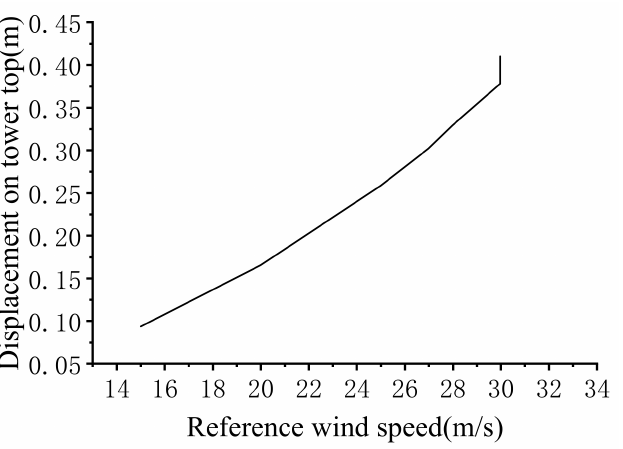
Figure 8. The variation curve of transmission tower top displacement with wind